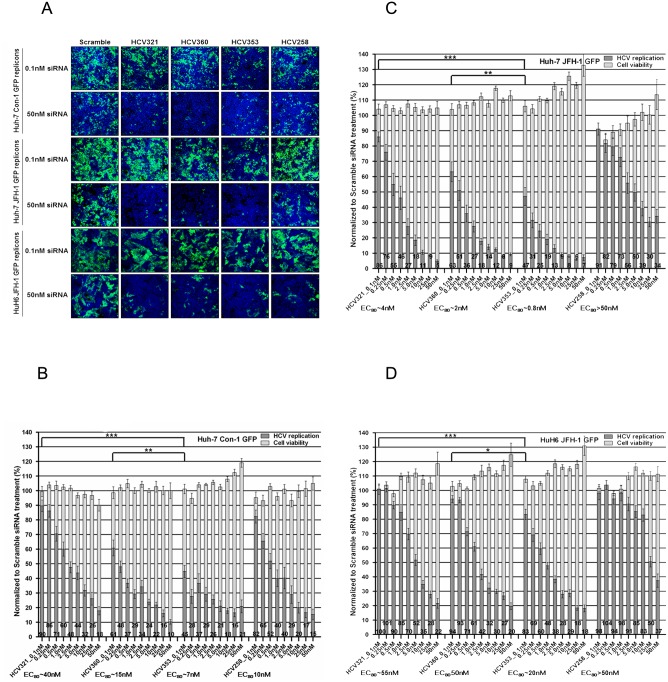
Dose-dependent antiviral effects of HCV IRES-specific siRNAs on the replication of subgenomic HCV replicons expressing a NS5A-GFP fusion protein.(A) Representative confocal images of GFP replicon cells after transfection with HCV-specific siRNAs. Replicon cells were PFA-fixed, and stained with Hoechst 33432 stain. Images of 0.1 and 50 nM siRNA transfections at 72 h post-transfection (p.t.) are shown (ImageXpress Ultra: 20x magnification). Overlaid images: cell nuclei (blue) and HCV RNA replicating cells (green). GFP replicon cells: (B) Huh-7 Con1, (C) Huh-7 JFH-1, and (D) HuH6 JFH-1 replicon cells were plated and transfected with 0.1–50 nM siRNAs targeting the viral genome and a scrambled control. At 72 h p.t., confocal images of GFP replicon cells were acquired and analyzed using an ImageXpress Ultra microscope and MetaXpress software, respectively. Results were normalized to the level of GFP-positive cells of the scrambled siRNA transfection control, which was set to 100%. The threshold of GFP was defined by treatment of replicon cells with an HCV replication inhibitor, which was set to 100% inhibition (data not shown). Fluorescence intensity above this threshold was considered to indicate active HCV replication. Data are presented as the mean ± SEM values for four wells measured in quadruplicate in two independent experiments (N = 32). Black columns indicate HCV RNA replication (GFP-positive cells); grey columns indicate cell viability (total cell number of Hoechst 33432 stained cell nuclei). The numbers on the bars indicate the residual percentage of GFP-positive cells. Asterisks indicate that the mean values are significantly different between samples (*p<0.05; **p<0.01; ***p<0.001).